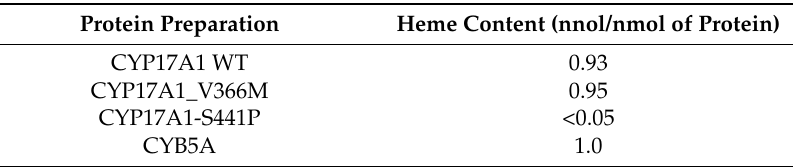
Table 4. Heme content of proteins used in